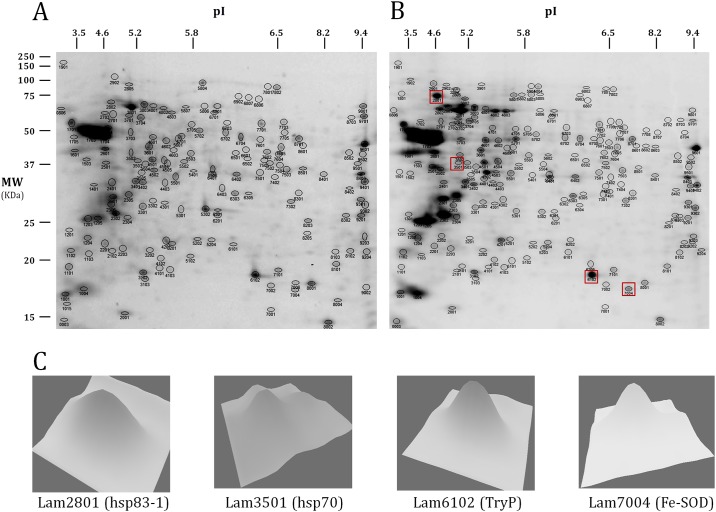
Examples of 2DE of total protein extracts of L. amazonensis promastigotes.(A) Early logarithmic (day 2) and (B) stationary phase (day 7). IEF was performed in a non-linear 3–10 pH interval. (C) 3D density graphs of spots Lam2801, Lam3501, Lam6102 and Lam7004 obtained with PD Quest software.